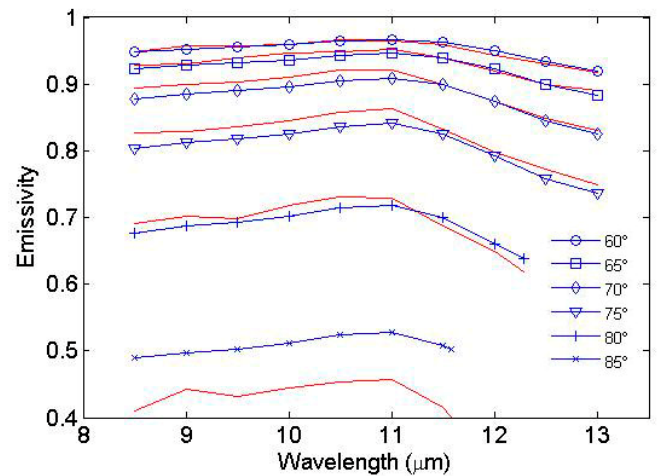
Figure 8. Comparison between simulated emissivity spectra and those measured by Branch et al. [29] at larger view angles. The measured emissivities (red lines) are reproduced from Figure 9 by Branch et al. [29]. Table 2. The bias and RMSD values between the simulated sea surface emissivity values and the measurements of Branch et al. Table 1. The bias and root mean square difference (RMSD) values between the simulated and measured sea surface emissivity values.